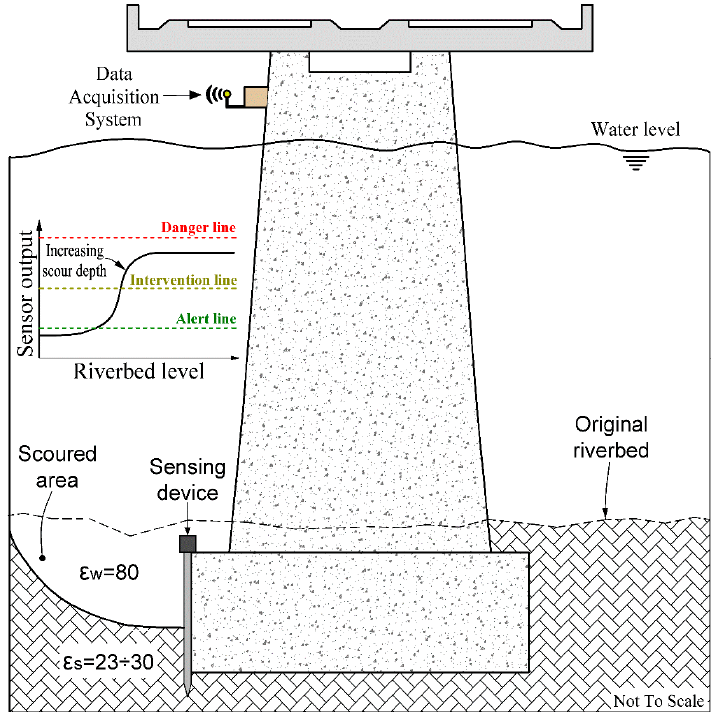
Figure 3. Conceptual monitoring application and anticipated outputs of the scour sensor into a bridge structure. Increased scour depth is expected to lead to a corresponding increase in the sensor output.